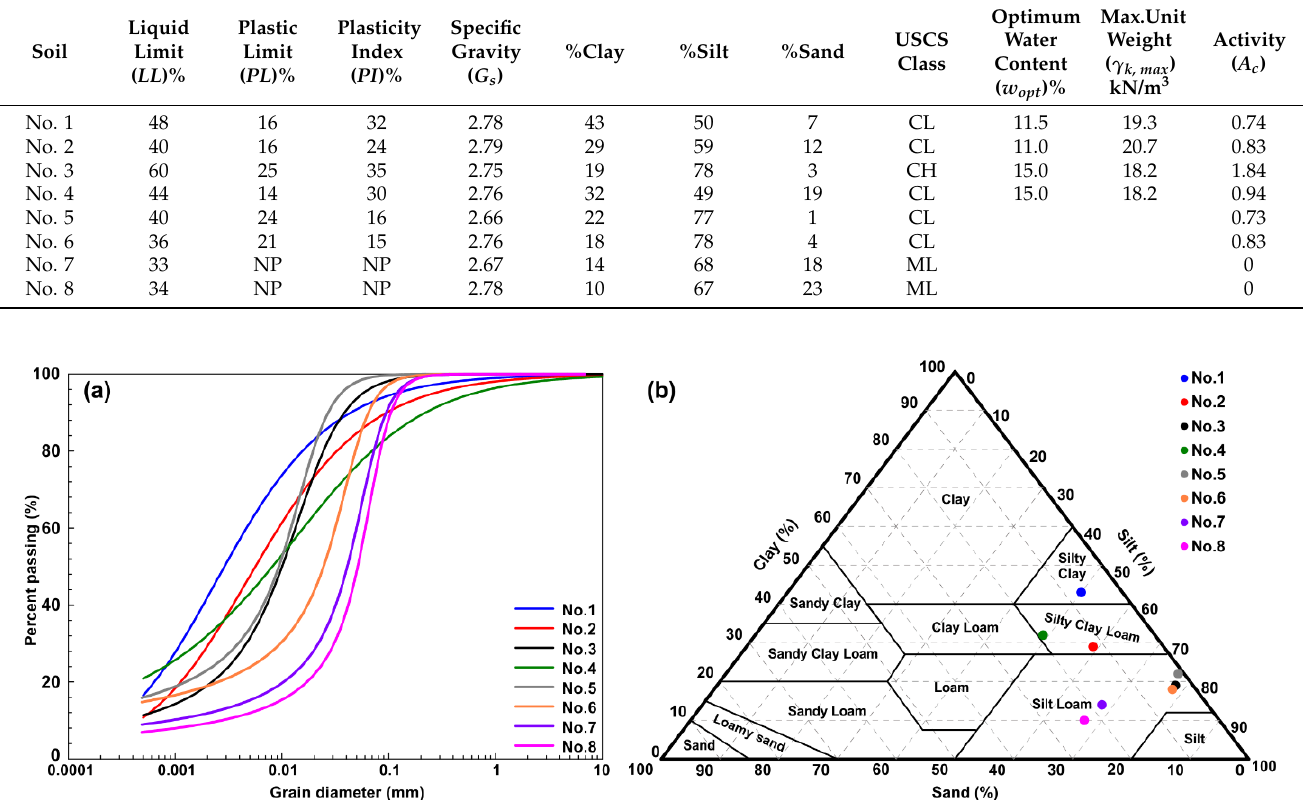
Figure 1. ( a ) Grain-size distribution and ( b ) textural triangle diagram of samples used in the study. Silt and clay particles are seen in the electron microscope image taken from the surface of the No. 1 soil in its natural state at 3000 × magnification (Figure 2). It is seen that clay particles smaller than 2 µ m are flat and leafy. On the other hand, silt particles are primarily in polyhedral form.